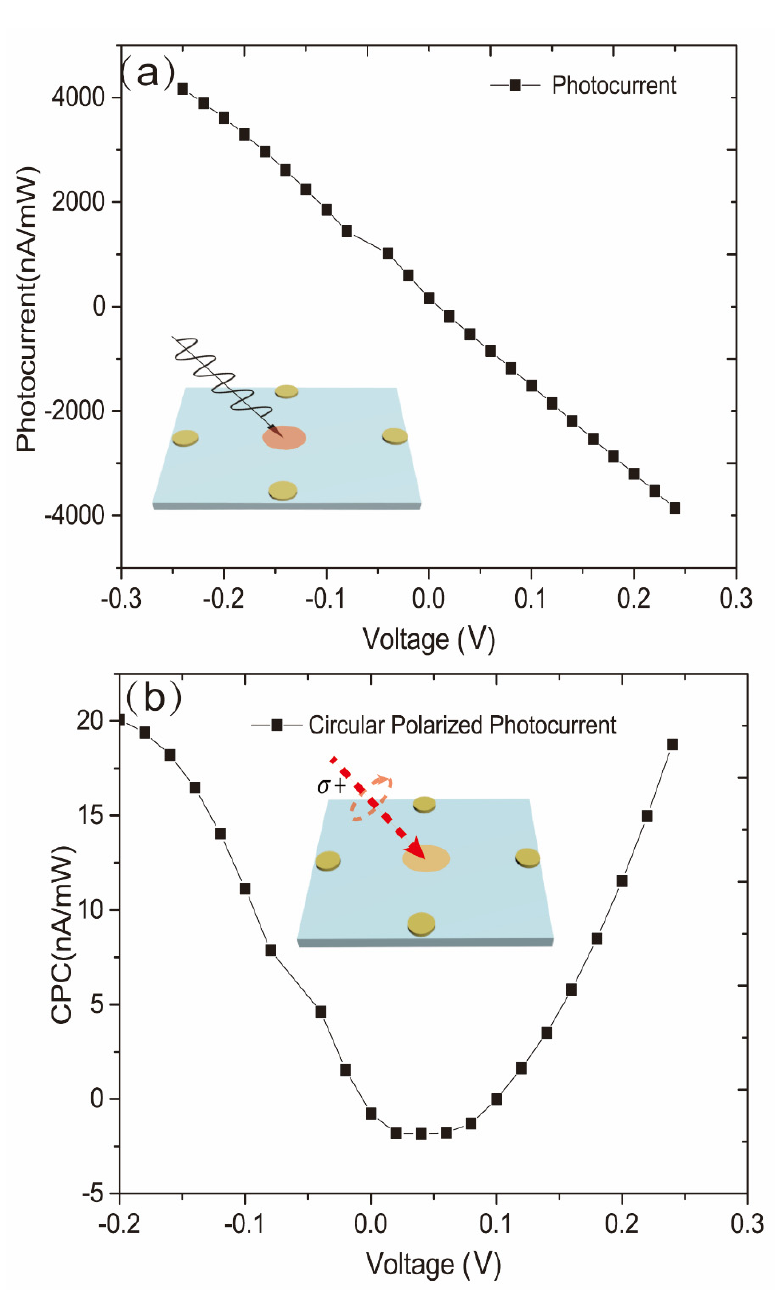
Figure 4. Dependence of ( a ) the ordinary photocurrent and ( b ) circularly polarized photocurrent on applied bias voltage when the incident angle is 30 ◦ and the incident plane of the laser is perpendicular to the measuring electrode.